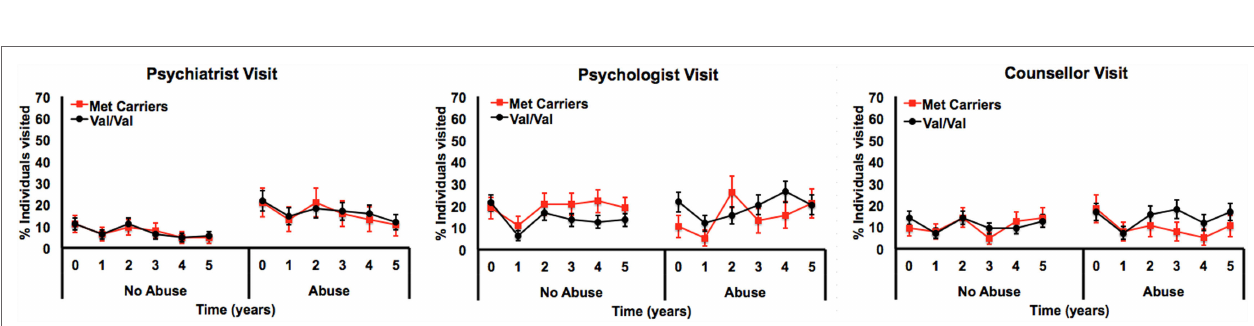
FigUre 5 | longitudinal measurements of psychosocial treatment by percent of individuals reported as having seen a psychiatrist, psychologist, or counselor once or more in the preceding 12 months, by genotype and history of severe child abuse